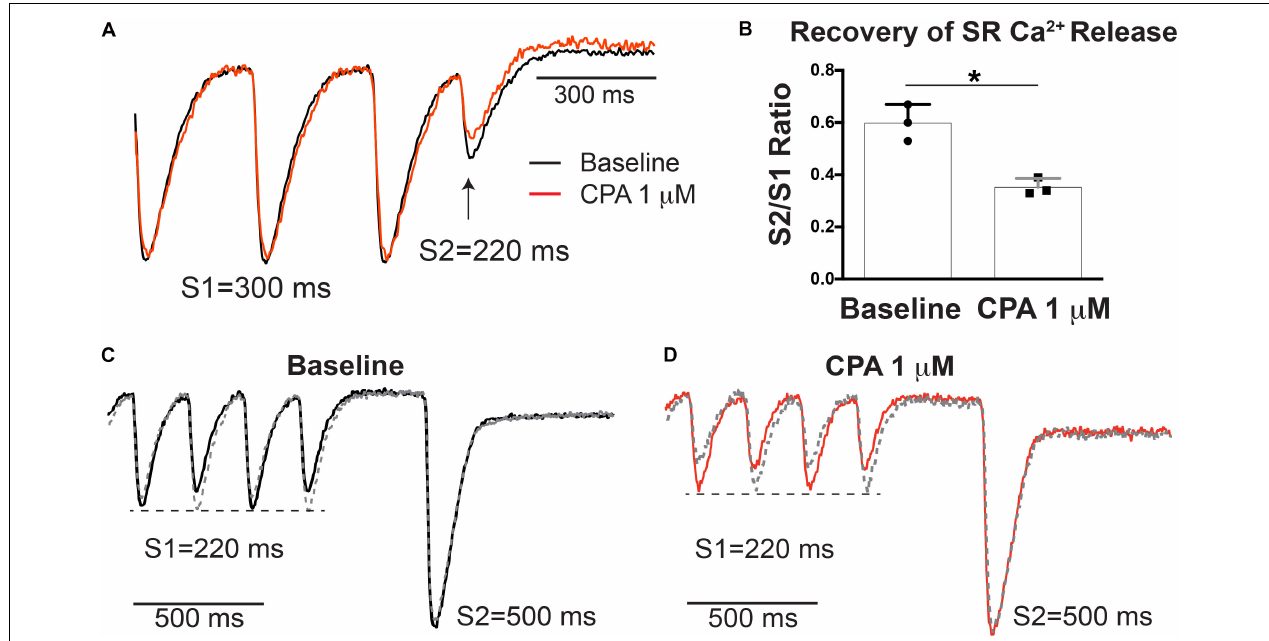
FIGURE 4 | Sarco-endoplasmic reticulum Ca 2 + -ATPase (SERCA) inhibition with cyclopiazonic acid (CPA) increased relative ryanodine receptor (RyR) refractoriness (A) . (B) S2/S1 ratio (S1 = 300, S2 = 220 ms) was significantly decreased with 1 µ M of CPA. Mean ± SD. N = 3 (* p < 0.05 vs. baseline). (C,D) Alternative S1–S2 protocol in which alternans was induced at S1 = 220 ms and a longer S2 (500 ms) was applied. The pacing protocol was repeated so that the last S1 was either a small (solid) or large (dashed) release. A similarly large sarcoplasmic reticulum (SR) Ca 2 + release occurred after a large or small release at baseline (C) and following 1 µ M of CPA (D) , indicating similar SR Ca 2 + load after small and large